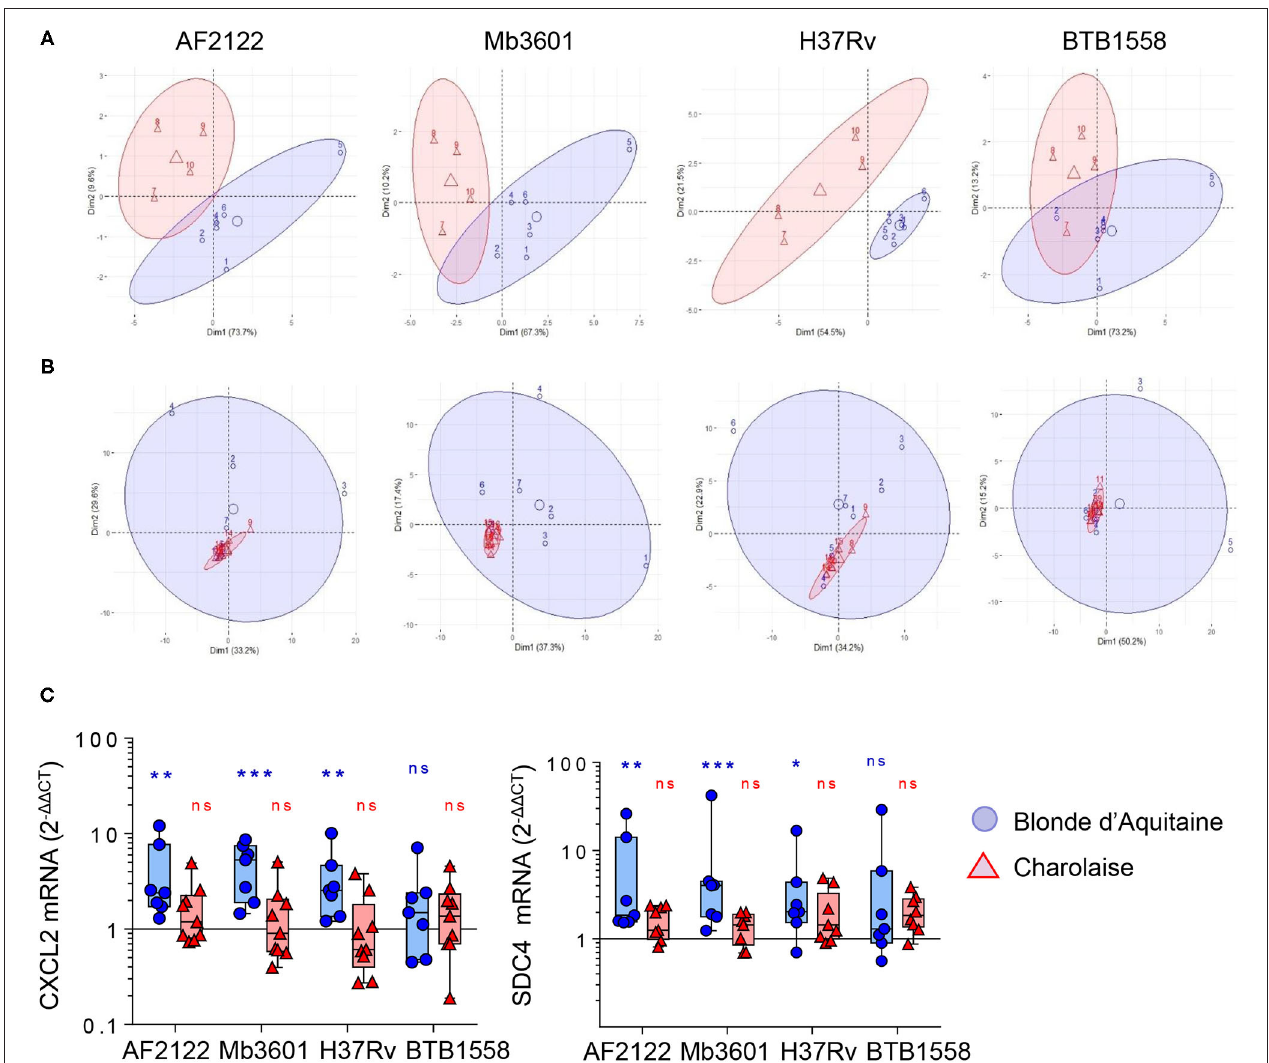
FIGURE 3 | Principal component analysis (PCA) of inflammatory lung tissue signature reveals differences between two beef cattle breeds after 2 days of infection by Mb or Mtb. (A) Fifteen cytokines and chemokines were measured in PCLS supernatants from Blonde d’Aquitaine or Charolaise cows 2 days after infection with four different mycobacterial strains. Raw data were used to run PCA in R studio. Individual data are shown ( n = 4 for Charolaise, red; n = 6 for Blonde d’Aquitaine, blue). The ellipses represent a confidence range of 90%. (B) PCA were built from the expression data of 96 genes (2 − 11 Ct ) obtained from precision-cut lung slice total RNA extracted 2 days after infection. Individual data are shown ( n = 9 for Charolaise, red; n = 7 for Blonde d’Aquitaine, blue). The ellipses represent a confidence range of 90%. (C) Two examples of differentially expressed genes. Individual data and the median and interquartile range in each group are presented ( n = 7 Blonde d’Aquitaine and n = 9 Charolaise) * p < 0.05; ** p < 0.01; *** p < 0.001. Two-way ANOVA test.